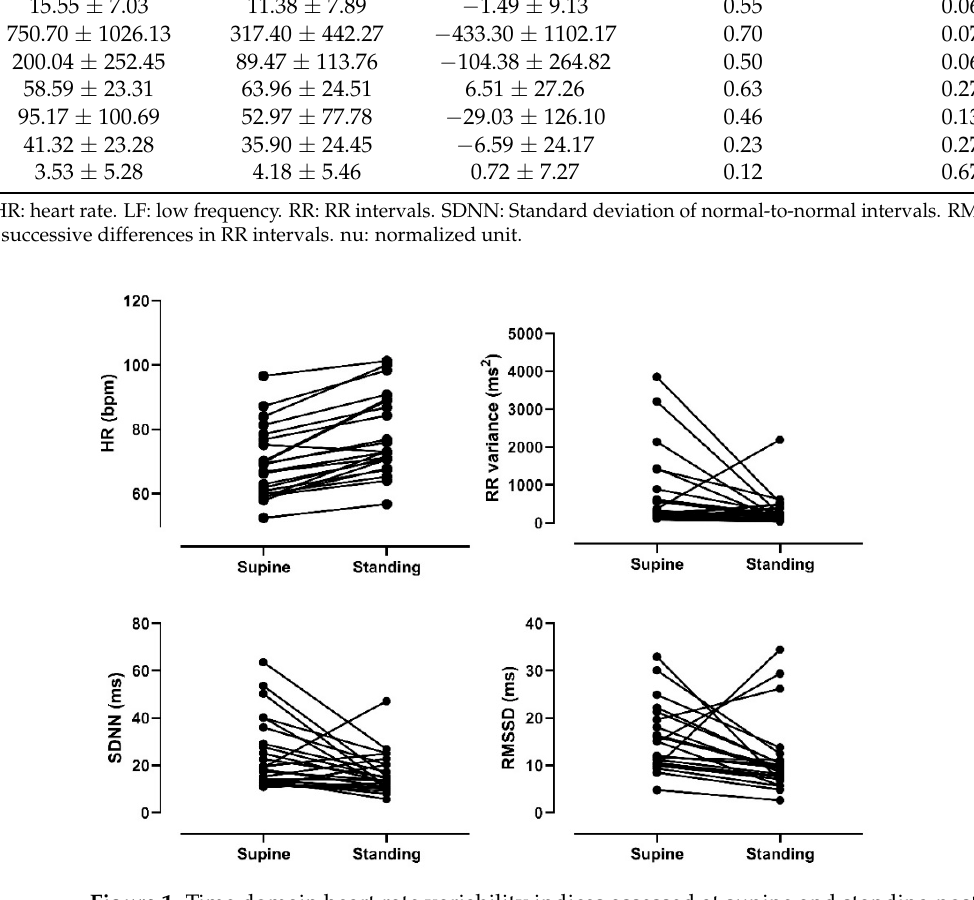
Table 3. Indices of heart rate variability evaluated in the supine (Sup) and standing position (Stand). Supine